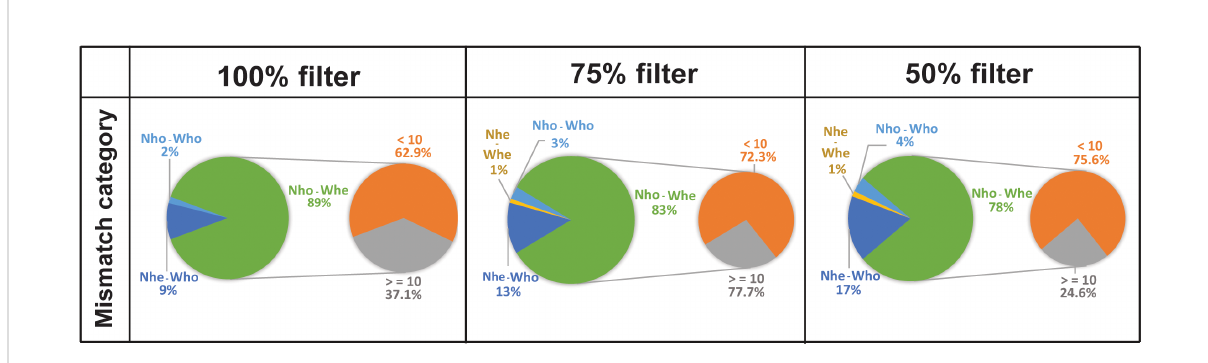
FIGURE 4 Percentage of ‘ discordant by genotype ’ loci for each fi ltered fi le in the combined dataset. The left pie of each panel shows the mean percentage of ‘ discordant by genotype ’ loci of each mismatch category for the NN-WN dataset comparing the genotypes in the two libraries for the same individual locus by locus. Each fi ltered fi le (100%, 75% and 50%) has been considered separately. Nho = homozygote for NN libraries, Who = homozygote for WN libraries, Nhe = heterozygote for NN libraries, Whe = heterozygote for WN libraries. Note that the percentage of discordant by genotype loci is only 8%, 10% and 5% of the total loci respectively. The pie on the right of each panel shows in detail how much Nho-Whe discordance was attributable to lower (<10 reads) and higher (>=10 reads) sequencing depth.